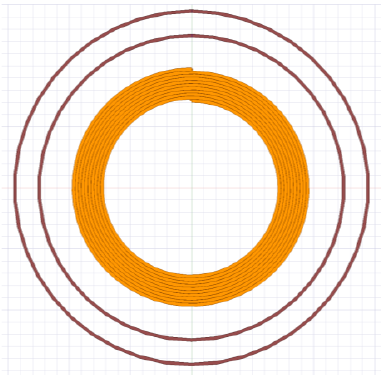
Figure 8. Simulated structure of the WPT coils.